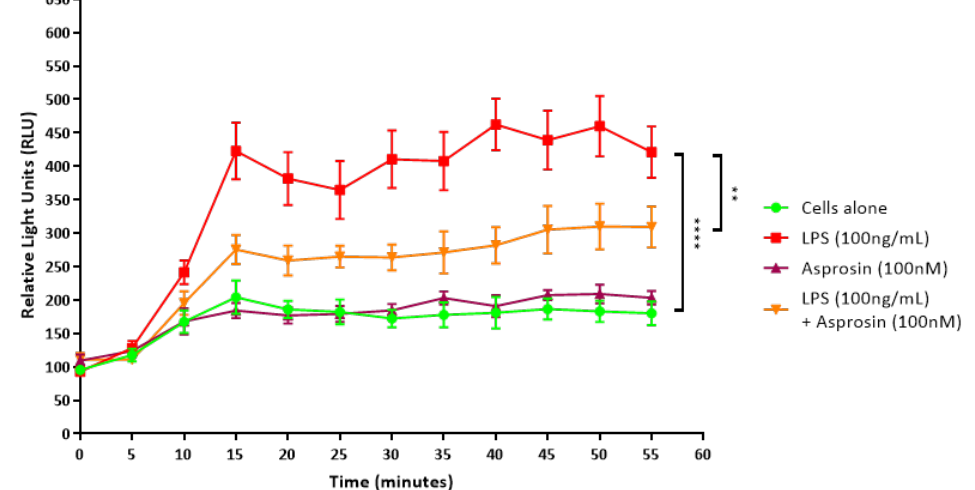
Figure 6. Asprosin attenuates LPS-induced superoxide release. To detect superoxide release, 500,000 THP-1-derived macrophage cells were treated with 20 µ M lucigenin and either 100 ng/mL lipopolysaccharide (LPS), 100 nM asprosin or both. Luminescence was measured every 5 min for 55 min. Data were compared using one-way ANOVA and Tukey’s multiple comparisons test ( n = 3). Data are presented as mean ± SEM; ** p < 0.01, **** p < 0.0001.